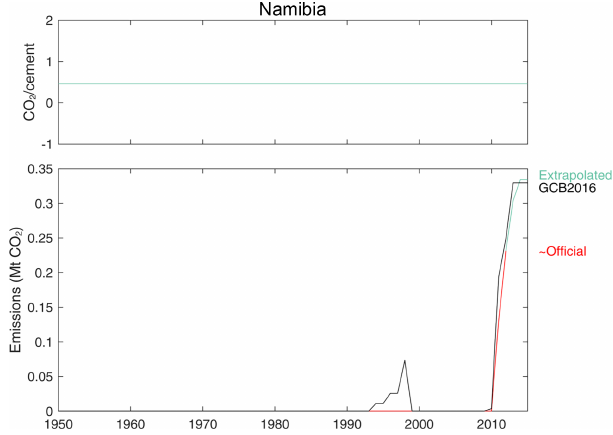
Figure D27. Revised cement emissions for